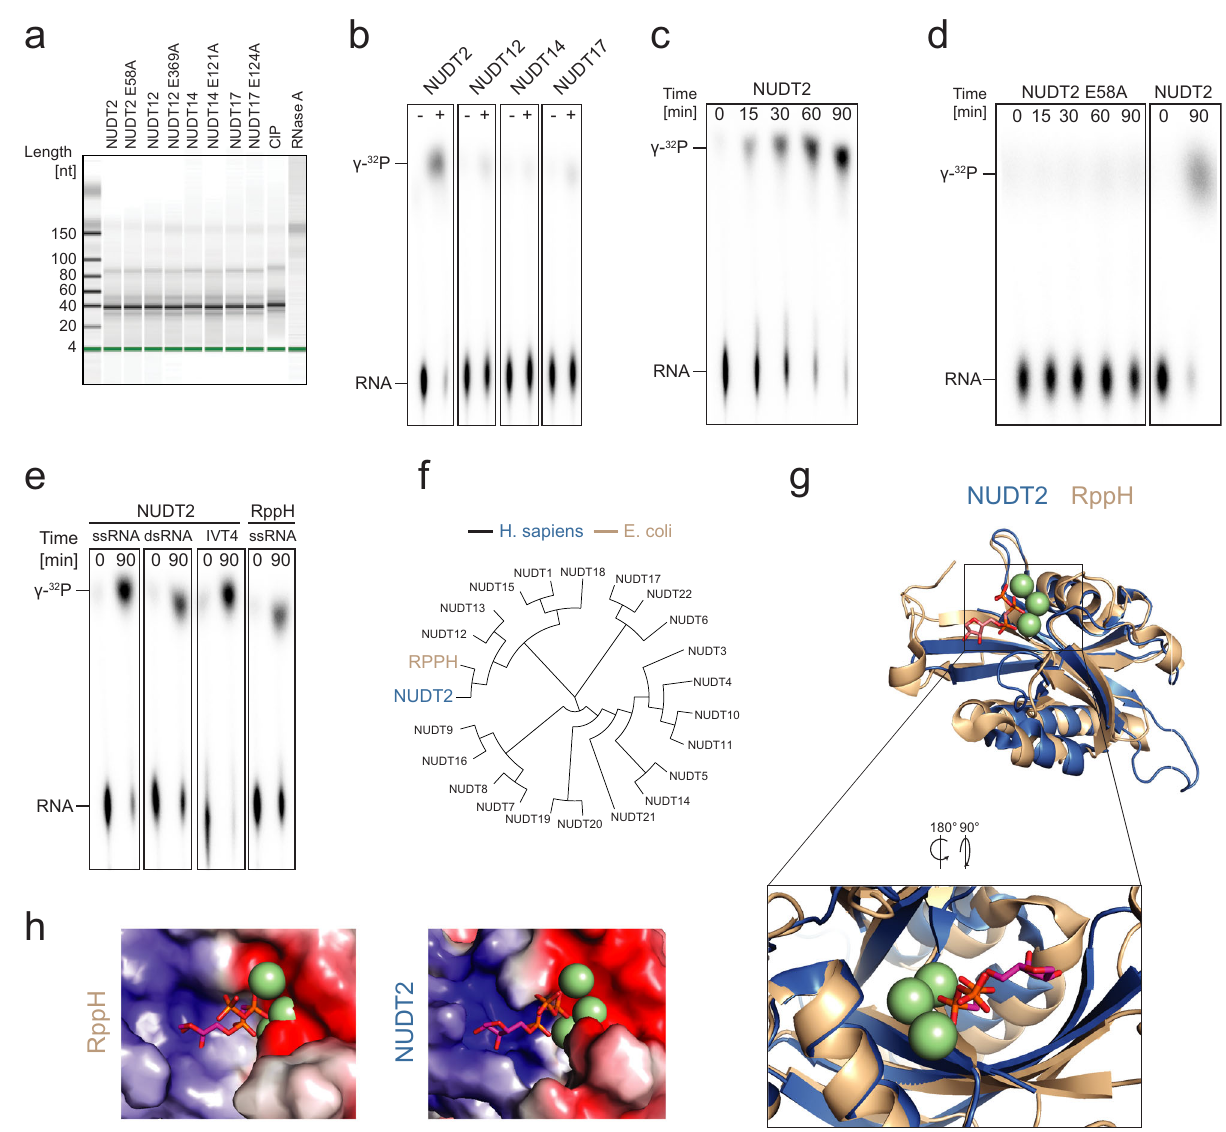
Fig. 2 Identi fi cation of NUDT2 as PPP-RNA phosphatase. a RNA was incubated for 3 h with the indicated Nudix hydrolase, and the integrity of the RNA was determined using a Bioanalyzer. One representative experiment of three is shown. b γ - 32 P-radiolabeled in vitro transcribed 44-mer ssRNA substrate was left untreated or incubated for 90 min with 600 nM NUDT2, NUDT12, NUDT14 or NUDT17 ( + ) or was left untreated ( − ). Reaction mixtures were analyzed by TLC and autoradiography. γ - 32 P: radiolabeled γ -phosphate; RNA: remaining input RNA after incubation. c As ( b ) but incubation for the time indicated at the top of the panel. 600 nM NUDT2 were used. d As ( c ) but 600 nM NUDT2 E58A or NUDT2 were used. e As ( b ) but γ - 32 P-radiolabeled in vitro transcribed single-stranded (ss-) or double-stranded (ds-) RNA generated by annealing an antisense oligo, or a RIG-I activating hairpin RNA (IVT4) were incubated with 600 nM NUDT2 and 5 U RppH, respectively. f Phylogenetic analysis of all human Nudix hydrolases and bacterial RppH was performed using MAFFT. g Structural alignment of the crystal structures of RppH (brown) with an RNA substrate (red sticks) (PDB: 4S2Y) and NUDT2 (blue) (PDB: 3U53) using PYMOL 57 . The green-colored magnesium ions spheres are essential for hydrolase activity. h Visualization of the electrostatic surface charges of RppH and NUDT2 displayed with the aligned RNA of the RppH structure using PYMOL. Acidic amino acids are depicted in red, and basic residues are shown in (Supplementary Fig. 3a). Phosphatase activity of CIP was higher, second position (A, G, U, and C) of the RNA (Fig. 3b). NUDT2 probably due to more ef fi cient or more complete depho- processed all constructs, irrespective of the length of the 5 ′ single- sphorylation of the RNA substrate. As expected, NUDT2 medi- stranded overhang (Fig. 3c). Moreover, NUDT2 was also able to ated phosphate release is dependent on a glutamic acid at the catalytic site since the NUDT2 E58A mutant or control proteins (NUDT14, NUDT14 E121A) failed to yield a considerable signal (Fig. 3a). To investigate the reactivity of NUDT2 on different substrates, we designed RNAs with or without different 5 ′ single-stranded overhangs and variable nucleotides at the fi rst (A, G) and the